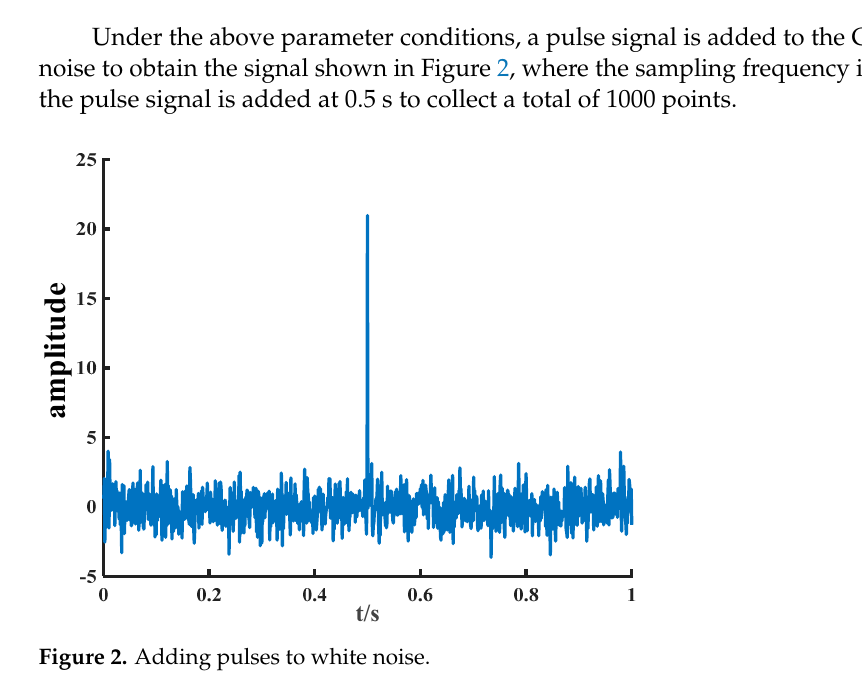
Figure 2. Adding pulses to white noise. The collected 1000 points were grouped into 200 points in each group. The third group contains the impulse signal, and the entropy values are calculated using multi − scale permutation entropy and multi − scale weighted permutation entropy, respectively. The results are shown in Figure 3.